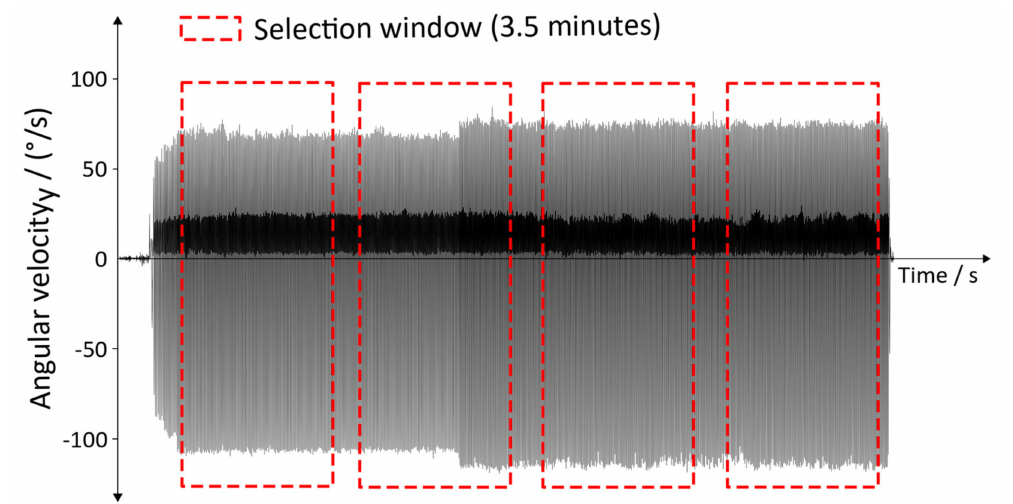
Figure 8. Selection windows for analyzing the